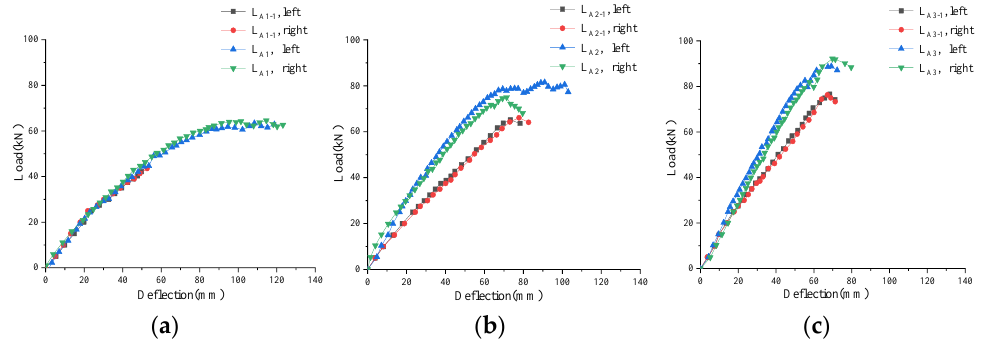
Figure 19. Load – displacement curve of group A. ( a ) 7 kN, 2 steel wires; ( b ) 7 kN, 4 steel wires; ( c ) 7 Figure 19. Load-displacement curve of group A (long-term beam). ( a ) 7 kN, 2 steel wires; ( b ) 7 kN, kN, 6 steel wires. 4 steel wires; ( c ) 7 kN, 6 steel